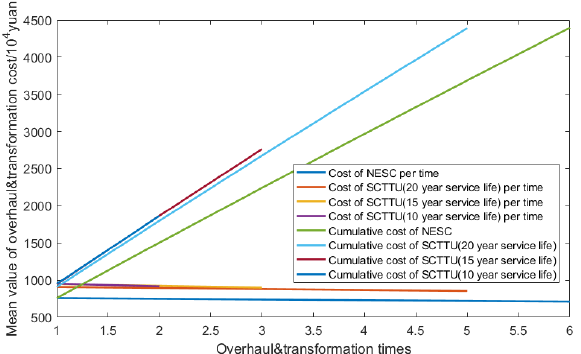
Figure 8. Comparison of overhaul and technical transformation cost curve between NESC and SCTTU.